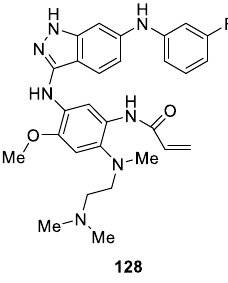
Figure 31. Chemical structure of indazole-based EGFR inhibitor 128 .